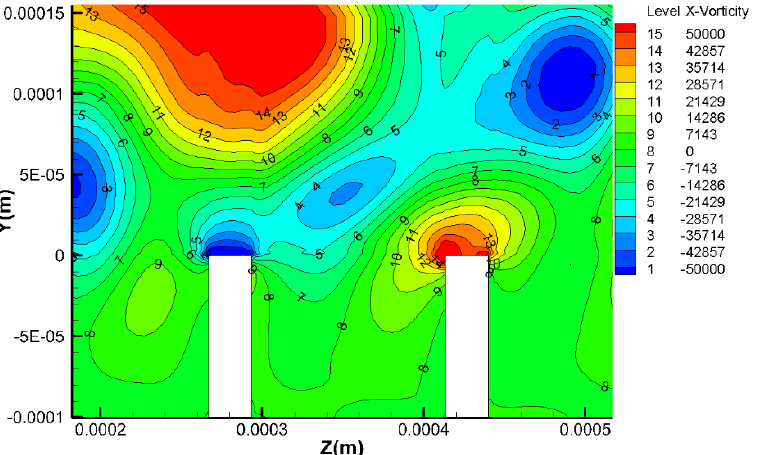
Figure 29. Vorticity cloud picture in the flow direction of the rectangular groove in the spanwise plane at x = 0.00375 m.